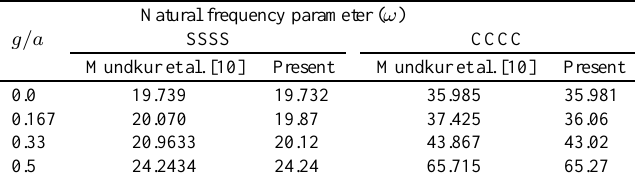
Comparison of natural frequency parameter Natural frequency parameter ( ω )